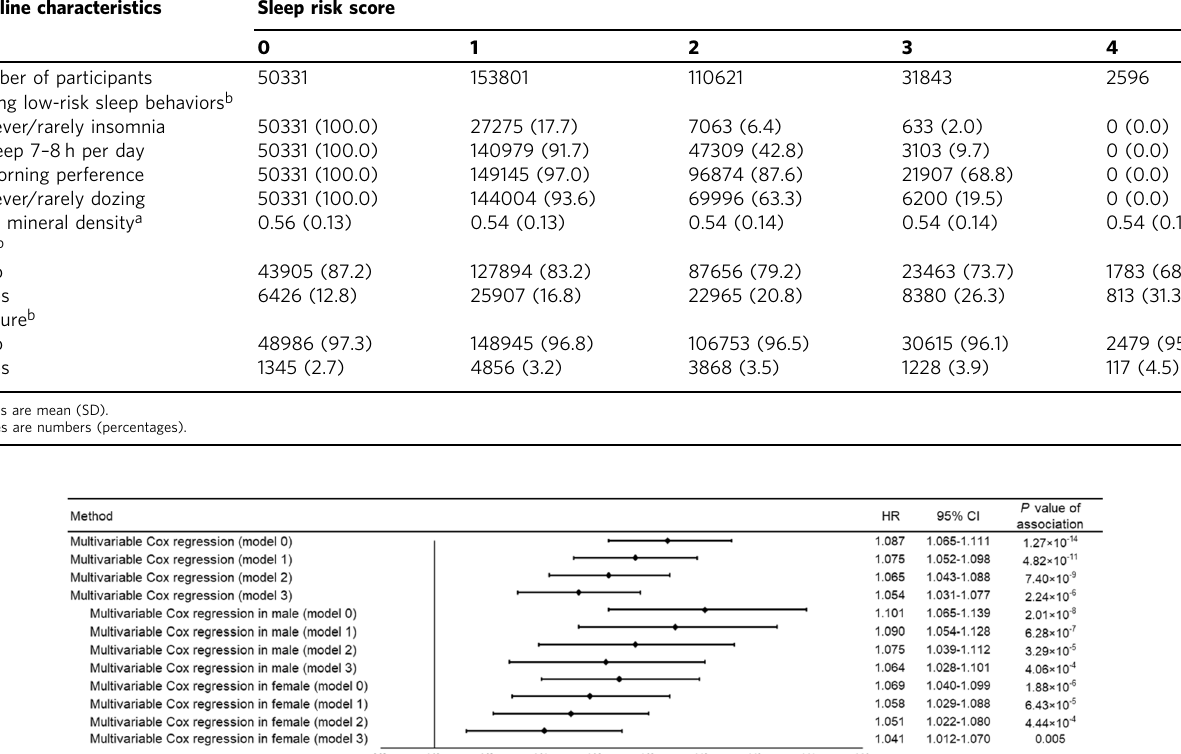
Table 2 Baseline characteristics of participants with different sleep behaviors in prospective studies. Baseline characteristics